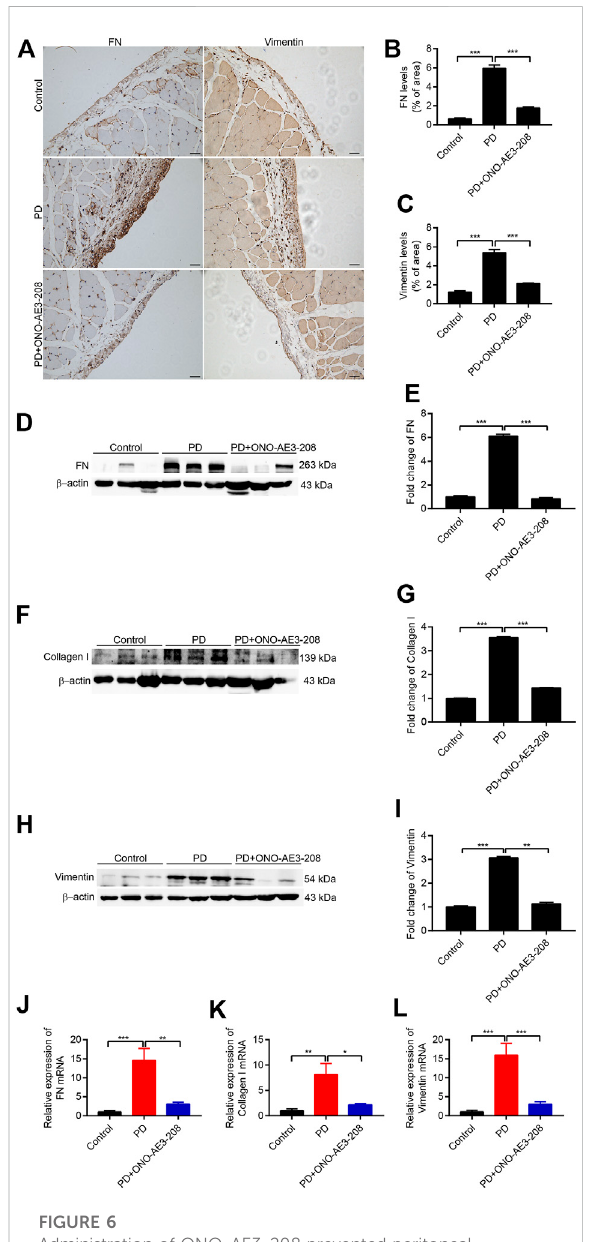
FIGURE 6 Administration of ONO-AE3-208 prevented